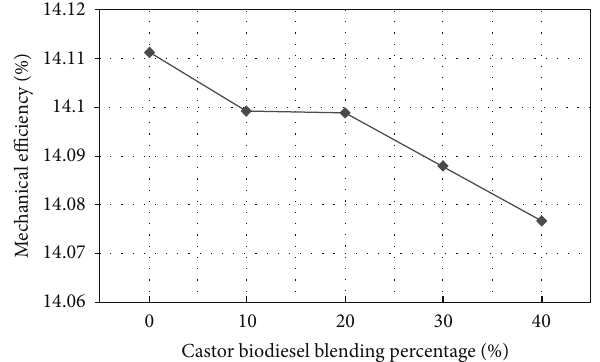
Figure 5: Engine power output versus castor biodiesel blending percentage.